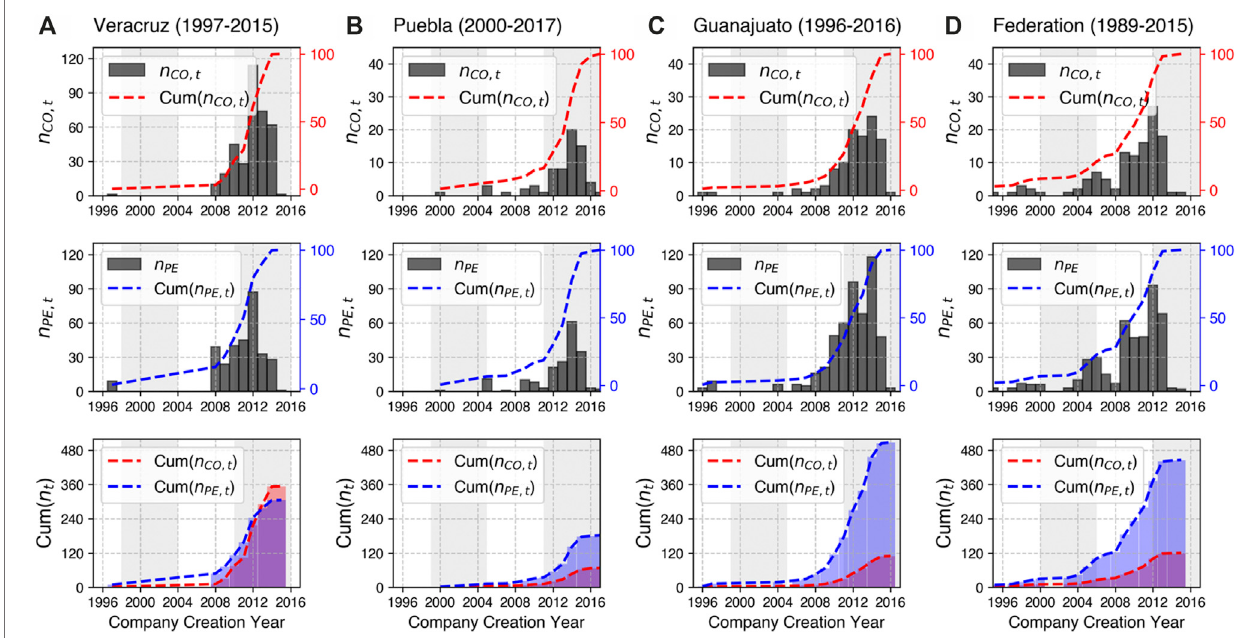
FIGURE 2 | Corporate temporal features per case. (A – D) ( fi rst row) Number and cumulative percentage of companies created per year, n CO , t and Cum ( n CO , t ), respectively;(secondrow)numberandcumulativepercentageofnewpersonnelperyear, n PE , t andCum( n PE , t ),respectively;(thirdrow)cumulativenumberofcompanies and personnel per year, Cum ( n CO , t ) and Cum ( n PE , t ), respectively. Light and shaded regions indicate the changes in the local or federal government administrations according to case. On top, the year period according to the fi rst and the last company created is indicated.